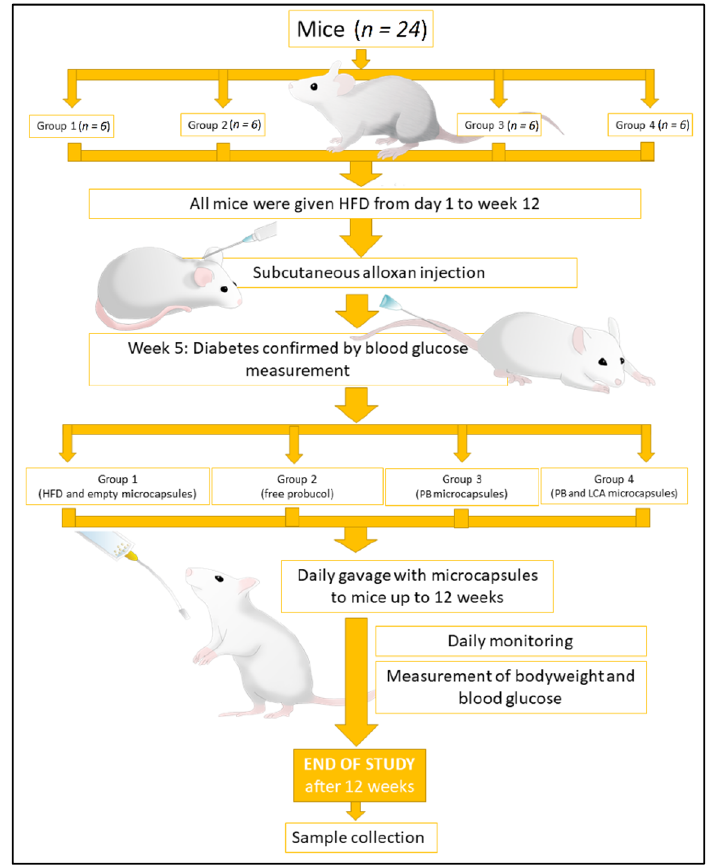
Figure 1. Summary of in vivo study.